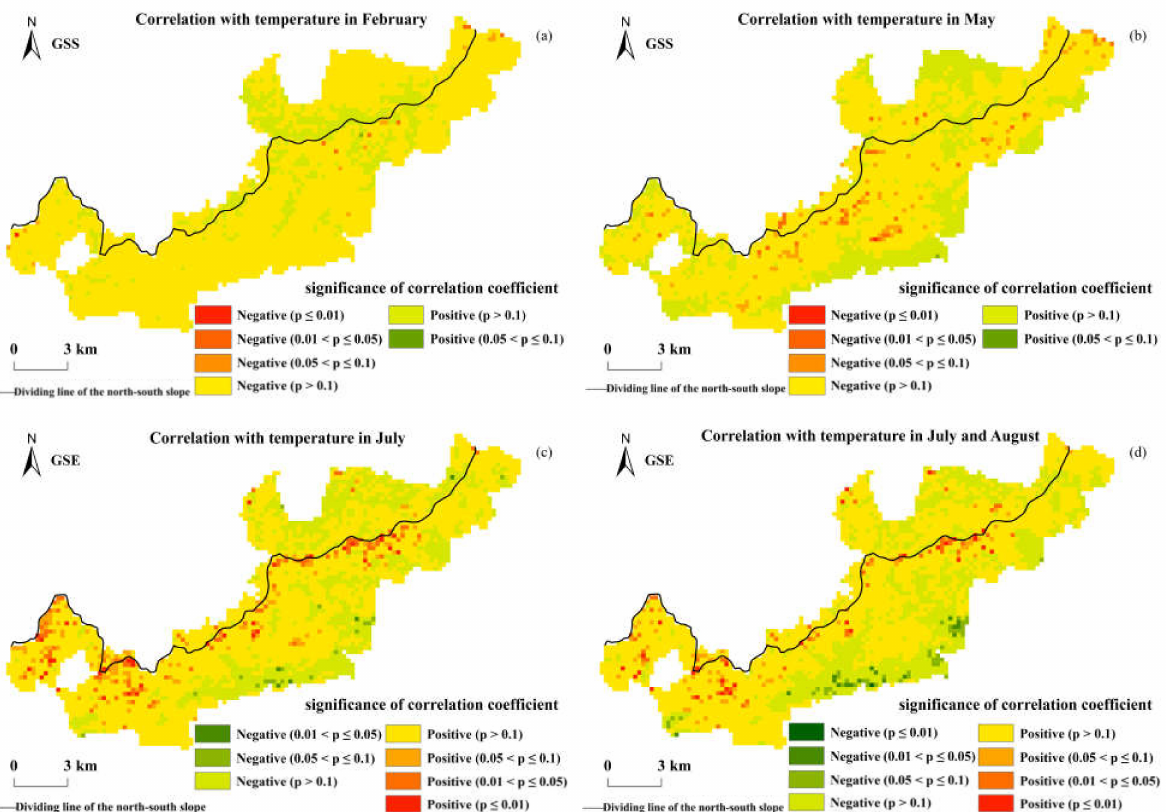
Figure 9. Spatial correlations between the GSS/GSE and temperature in Niubeiliang Reserve from 2000 to 2017. ( a ) Correlation between the GSS and temperature in February; ( b ) correlation be- tween the GSS and temperature in May; ( c ) correlation between the GSE and temperature in July; ( d ) correlation between the GSE and temperature in July and